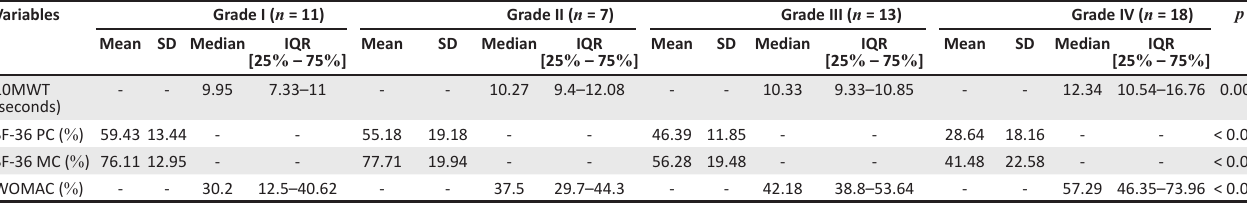
TABLE 6: Comparison of activity and participation based on grades of hip osteoarthritis. Variables Grade I ( n =